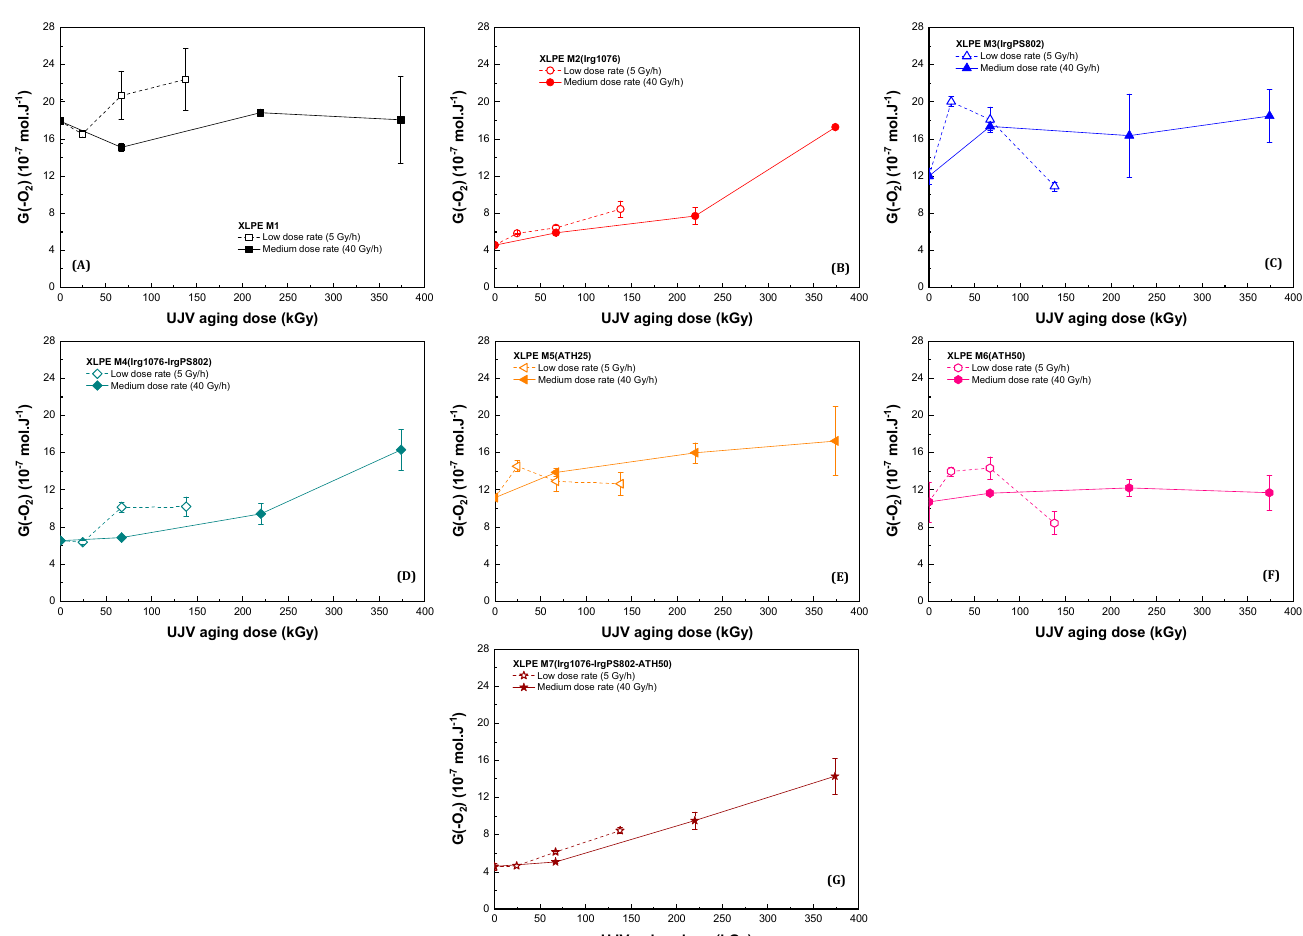
Figure 4. Oxygen consumption radiation chemical yields evolution as a function of dose at two different dose rates (open symbols for 5 Gy · h − 1 and solid symbols for 40 Gy · h − 1 ), for ( A ) XLPE M1, ( B ) XLPE M2(Irg1076), ( C ) XLPE M3(IrgPS802), ( D ) XLPE M4(Irg1076-IrgPS802), ( E ) XLPE M5(ATH25), ( F ) XLPE M6(ATH50), and ( G ) XLPE M7(Irg1076-IrgPS802- ATH50).